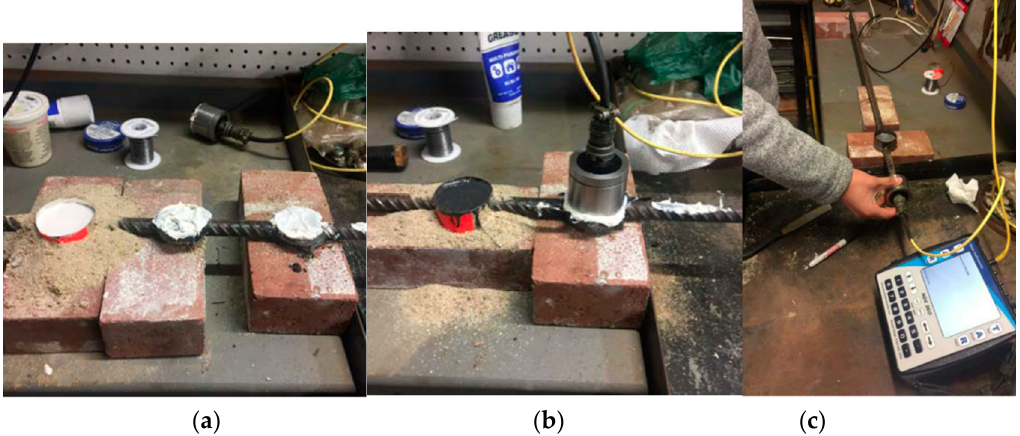
Figure 6. Attachment options: ( a ) Right to left: coupling via a solder pad, coupling via an epoxy pad curing in sheet metal form, and gypsum cement poured into sheet metal form; ( b ) Right to left: ground rebar and coupling with white grease, solder and epoxy pads fully cured; ( c ) Transmitter at the end of the rebar.